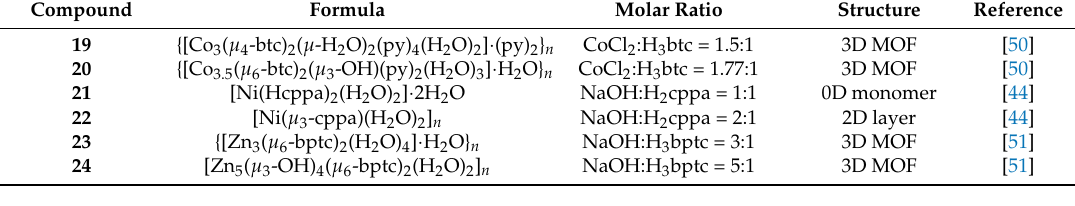
Table 3. Selected examples of CPs showing an effect of reagents molar ratio on product structure. Compound